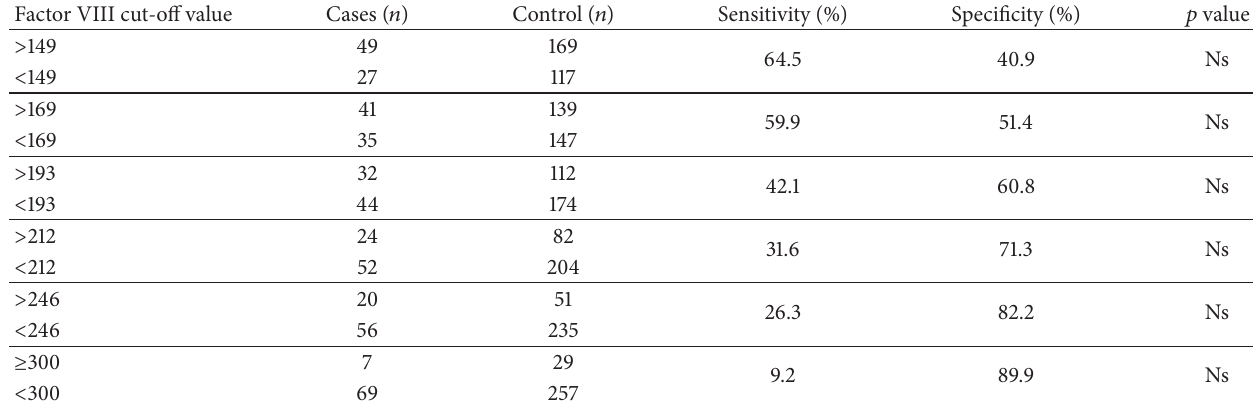
Table 2: Sensitivity and specificity value of VIII at different cut-off